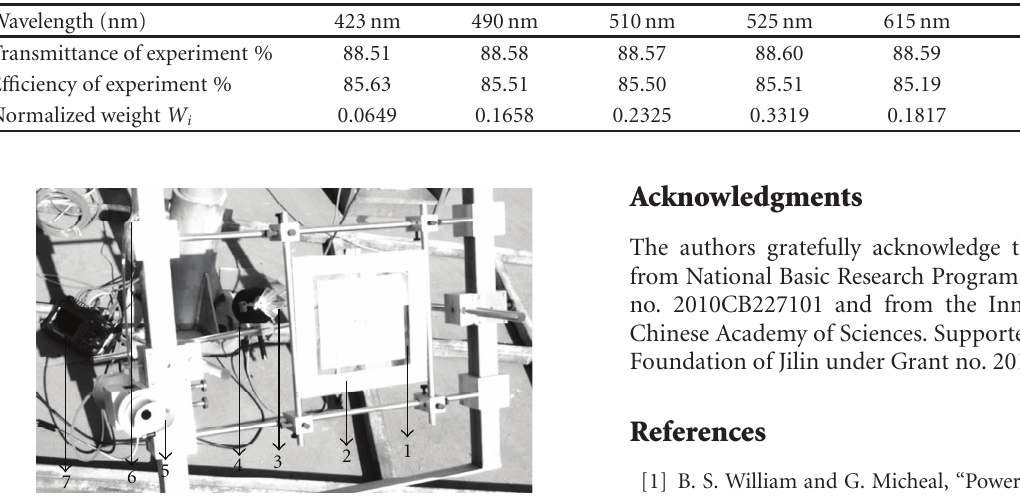
Table 4: Experimental transmittance and concentration e ffi ciency of concentration system for di ff erent monochromatic light.